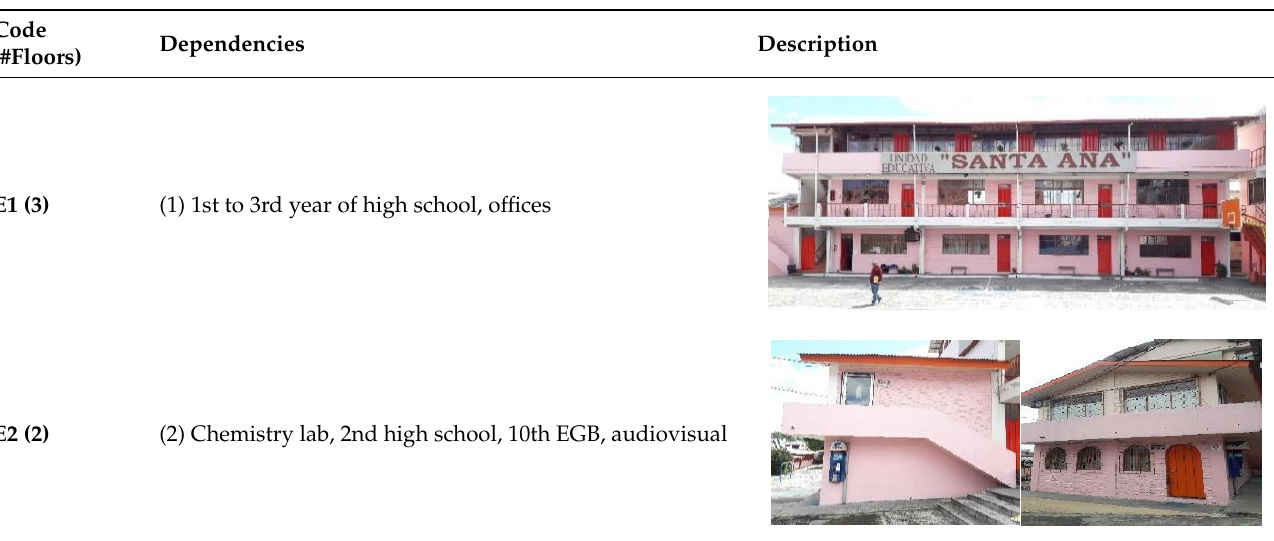
Figure 4. Sketch of the Santa Ana educative unit. Table 10. Dependence of the Santa Ana School complex.